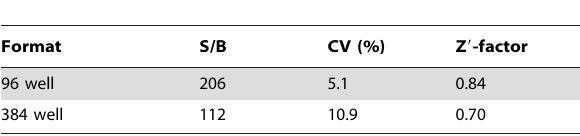
Table 1. Well-to-well reproducibility of automated ISRE activity assay for 2fTGH-ISRE-CBG99 cells treated with IFN- b (1000 U/ml for 7 h) versus DMSO vehicle alone.